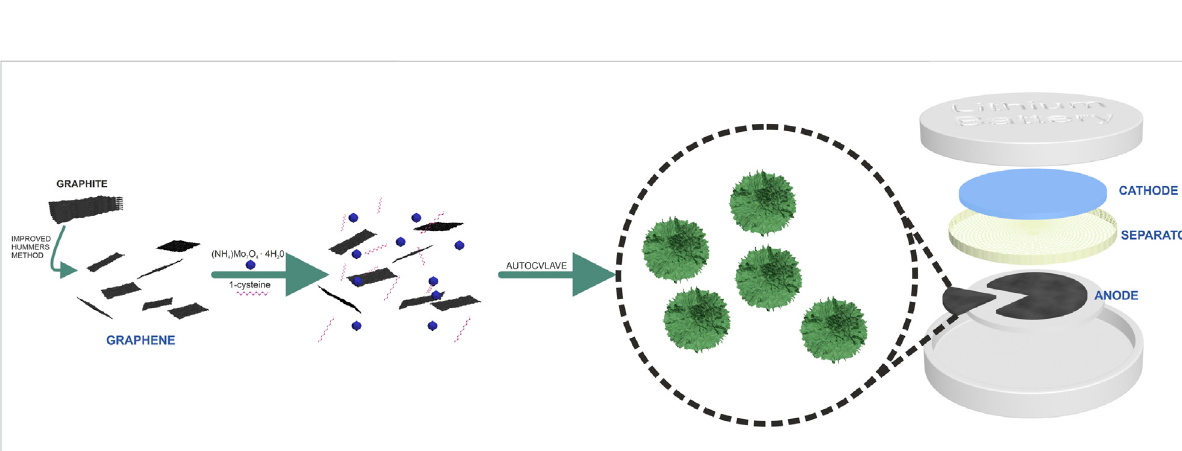
SCHEME 1 Schematic illustration of synthesis and application of GO/MoS 2